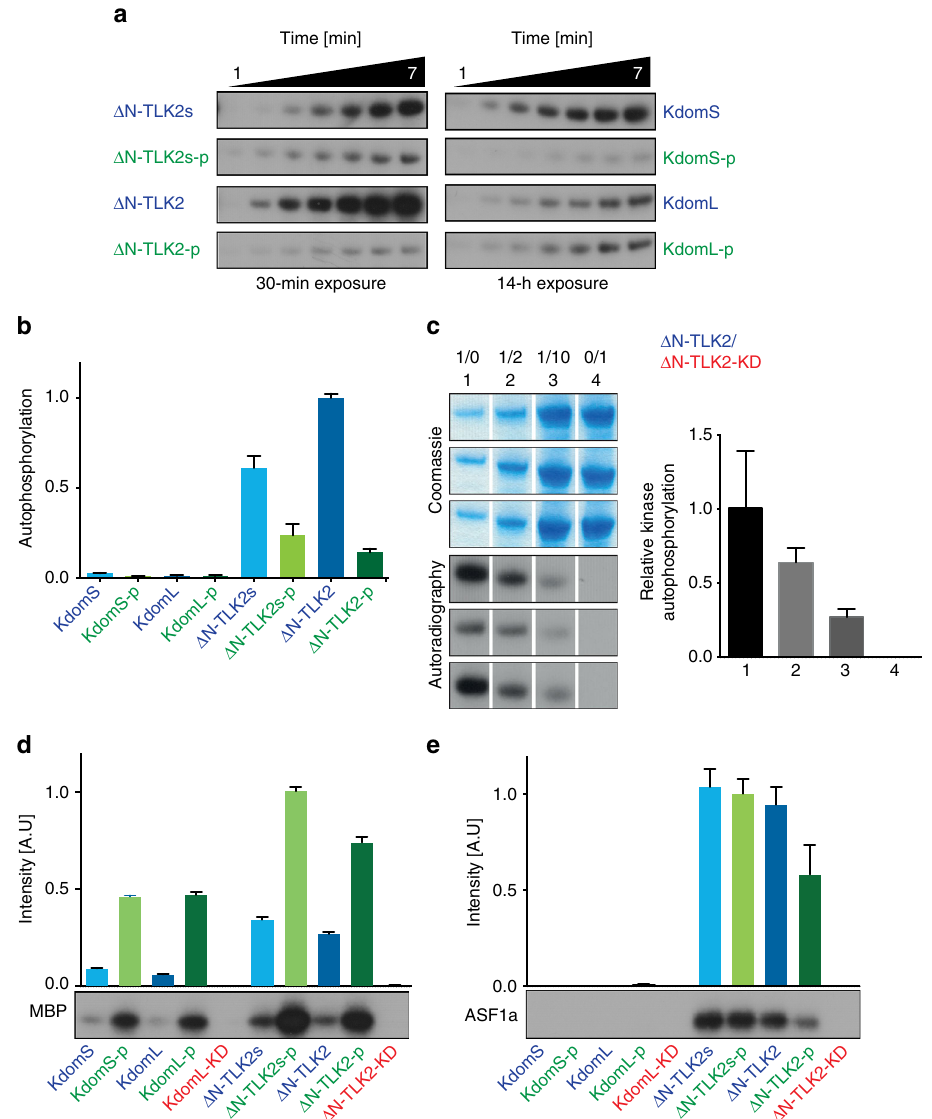
Fig. 2 Catalytic activity depends on TLK2 autophosphorylation. a Autoradiograms of TLK2 autophosphorylation activity for the kinase domain and the Δ N- TLK2 constructs after a 30-min or 14-h exposure, respectively (see Supplementary Figure 4a for SDS-PAGE and the initial velocity plots). b Quanti fi cation of the autophosphorylation assay showing that the kinase domain is not ef fi cient as the Δ N-TLK2 constructs. The unphosphorylated Δ N-TLK2 displays the larger activity in autophosphorylation. Data points indicate the relative autophosphorylation normalized to the autophosphorylation activity of Δ N-TLK2 (mean ± s.d., n = 3 biological replicates). See Supplementary Figure 4 for the details of the autophosphorylation rates of KdomL-p and Δ N-TLK2-p. c The autophosphorylation of Δ N-TLK2 is a unimolecular reaction. The increasing ratios of the Δ N-TLK2-KD inactive mutant diminished the activity of the kinase. The data points indicate the relative autophosphorylation of the Δ N-TLK2/ Δ N-TLK2-KD reactions normalized to the activity of point 1 (mean ± s.d., n = 3 biological replicates). d , e Phosphorylation of TLK2 substrates. The activity is represented in a histogram for MBP and ASF1a phosphorylation by various TLK2 constructs. The data points indicate the relative substrate phosphorylation for the TLK2 constructs normalized to the TLK2 construct with the highest activity (mean ± s.d., n = 3 biological replicates). See Supplementary Figure 4 for autoradiograms and SDS-PAGE for MBP and ASF1a